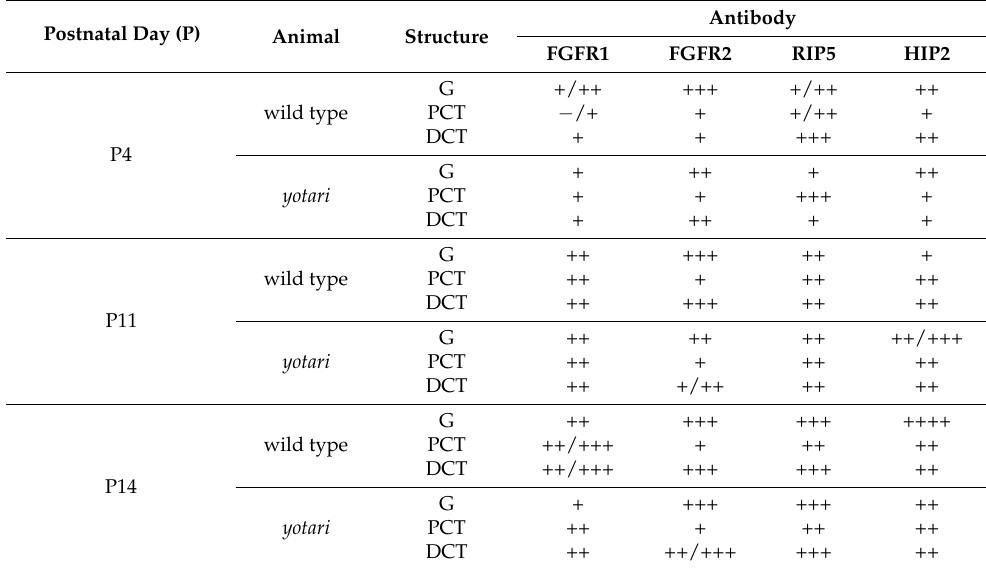
Table 2. Staining intensity of specific antibodies in the kidneys of yotari and wild-type mice at postnatal days P4, P11, and